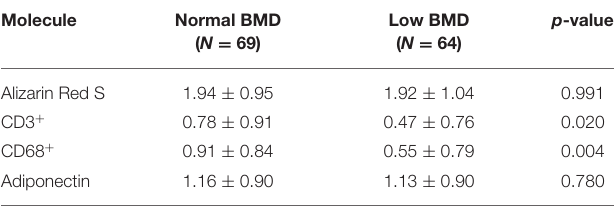
TABLE 3 | Histological scores of atherosclerosis patients with normal and low BMD. Molecule Normal BMD ( N = 69)